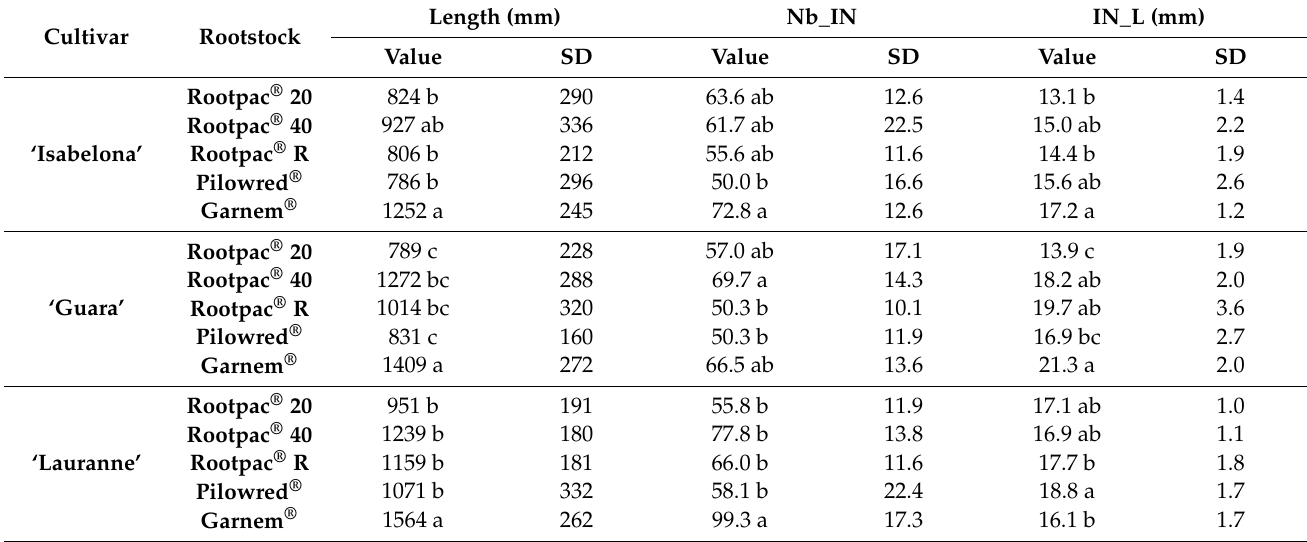
Table 1. Analysis of architectural traits (shoot length, number and length of internodes) related to vigor of two-year-old branches of 15 scion/rootstock combinations of